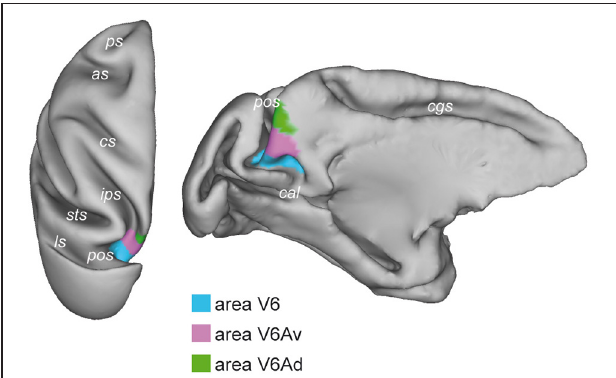
FIGURE 1 | Brain location of macaque area V6. Dorsal ( left ) and medial ( right ) views of the surface-based 3D reconstructions of the ATLAS brain of the macaque obtained by CARET (Computerized Anatomical Reconstruction and Editing Toolkit, http://brainvis.wustl.edu/wiki/index.php/Caret:About) (Van Essen et al., 2001) showing the extent of area V6 (light blue) on the left hemisphere. pos, parieto-occipital sulcus; cal, calcarine sulcus; cgs, cingulate sulcus; ips, intraparietal sulcus; sts, superior temporal sulcus; ls, lunate sulcus; cs, central sulcus; as, arcuate sulcus; ps, principal